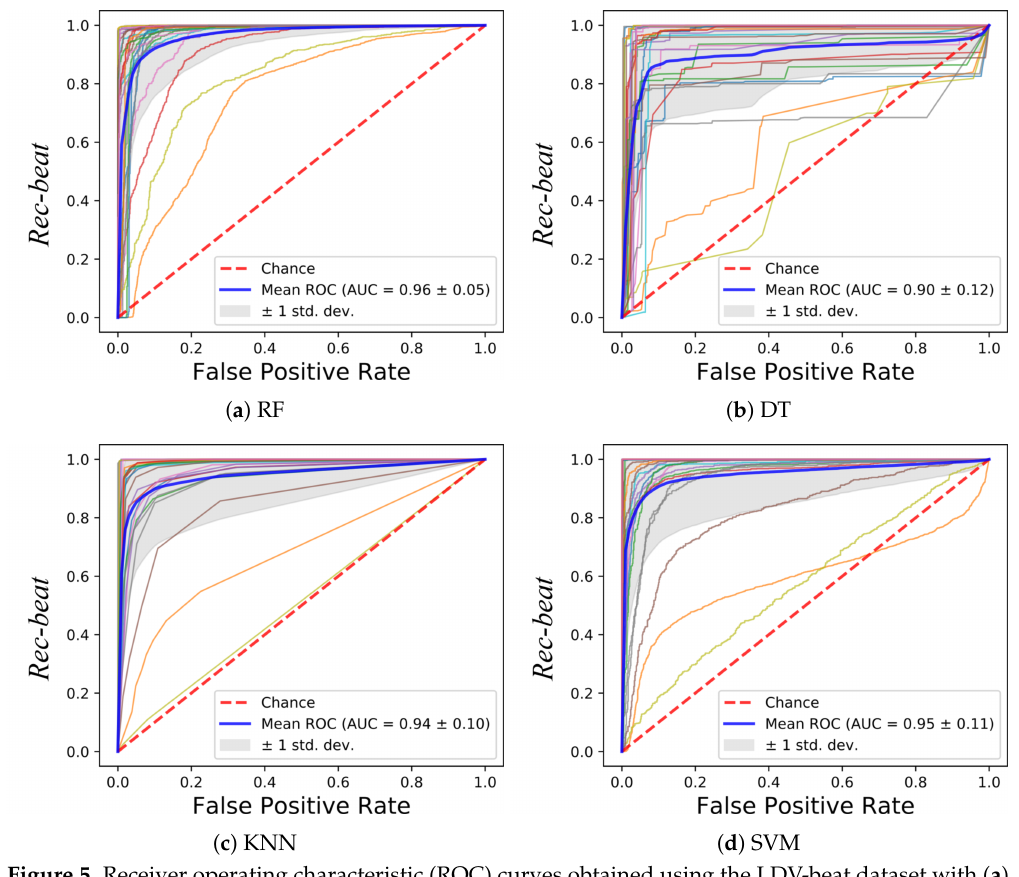
Figure 5. Receiver operating characteristic (ROC) curves obtained using the LDV-beat dataset with ( a ) Random Forest (RF), ( b ) Decision Tree (DT), ( c ) K-Nearest Neighbor (KNN) and ( d ) Support Vector Machines (SVM). Each ROC refers to a subject. The area (AUC) under the ROC is shown, too.